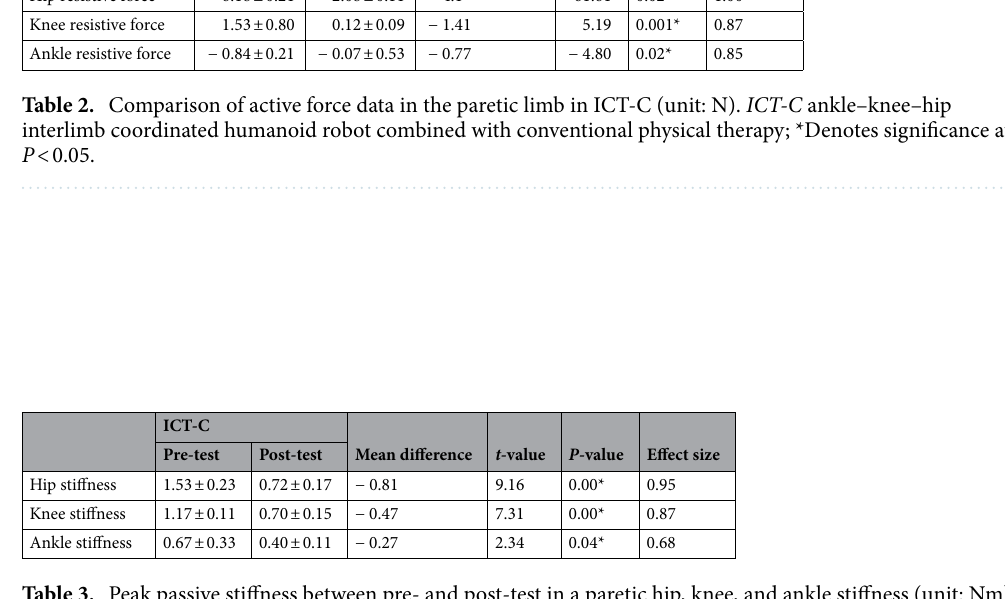
Table 3. Peak passive stiffness between pre- and post-test in a paretic hip, knee, and ankle stiffness (unit: Nm). ICT-C ankle–knee–hip interlimb coordinated humanoid robot combined with conventional physical therapy; *Denotes significance level at P <